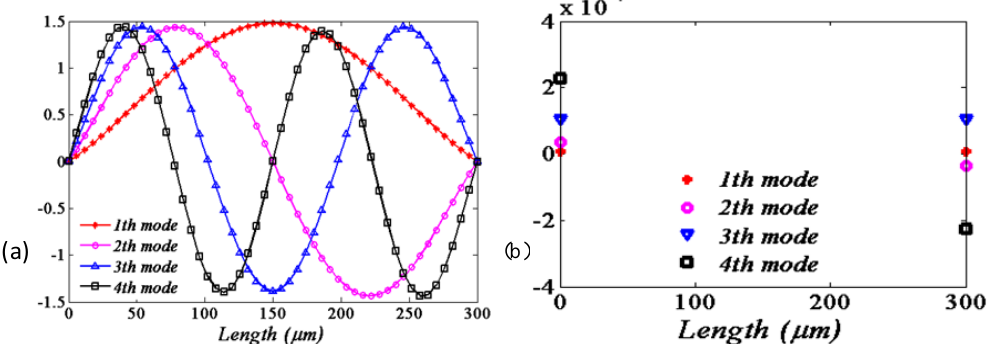
Figure 6. ( a ) First four mode shapes corresponding to the natural frequencies of Table 3; ( b ) The boundary displacement of each modal.